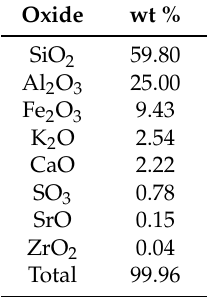
Table 4. Chemical composition of FA.